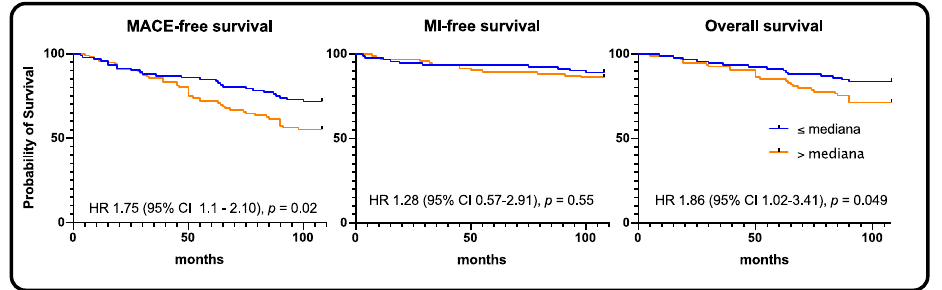
Figure 2. Whole population—Kaplan–Meier curves for MACE, myocardial infarction, and all-cause death, respectively.